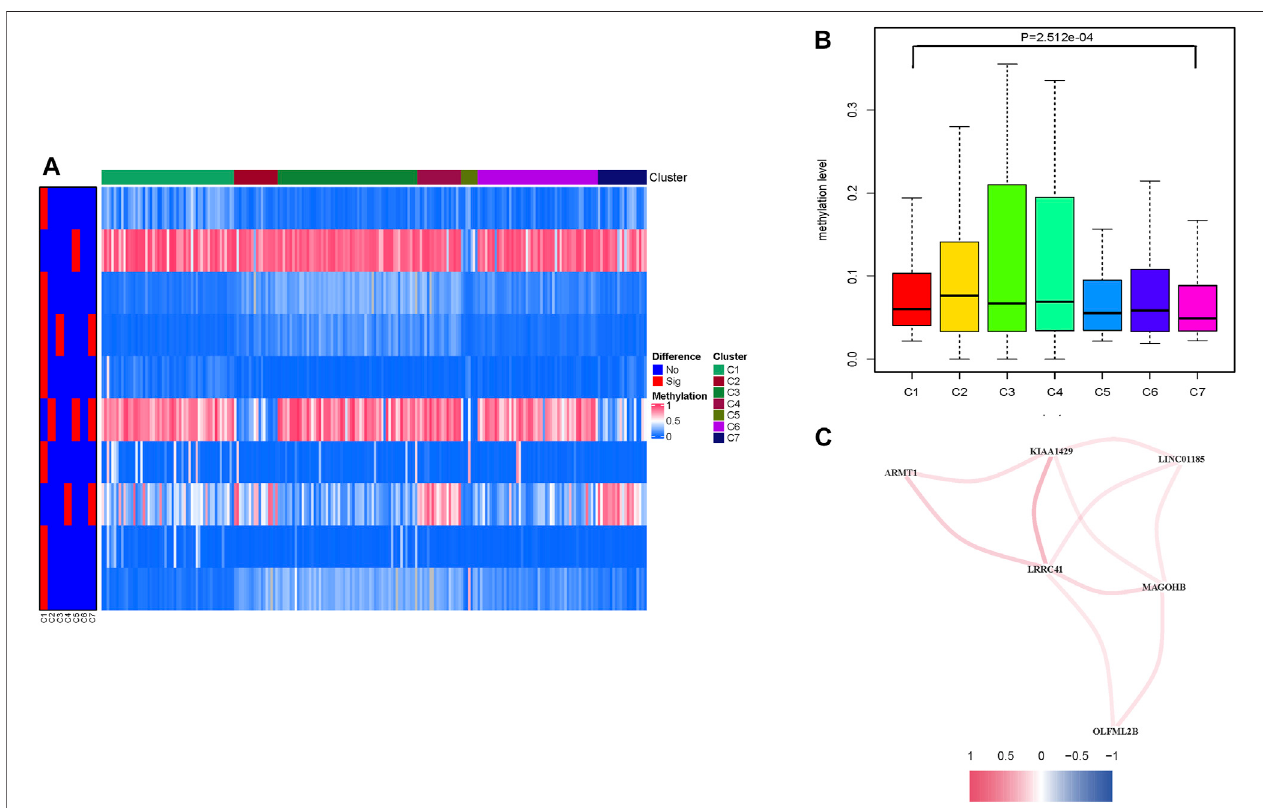
FIGURE 2 | Levels of prognosis-related DNA methylation sites of different HCC clusters. (A) Heatmap of abnormally expressed methylation sites in the seven subtypes. The heat rectangle on the left map: red represents statistically signi fi cant difference, whereas blue represents no signi fi cance. (B) Comparison of the methylationlevelsamongdifferentclusters. (C) Correlationanalysisbetweenmethylationcandidategenes(LRRC41,KIAA1429,LINC01185,MAGOHB,OLFML2B,and ARMT1). Red represents positive correlation, while blue represents negative